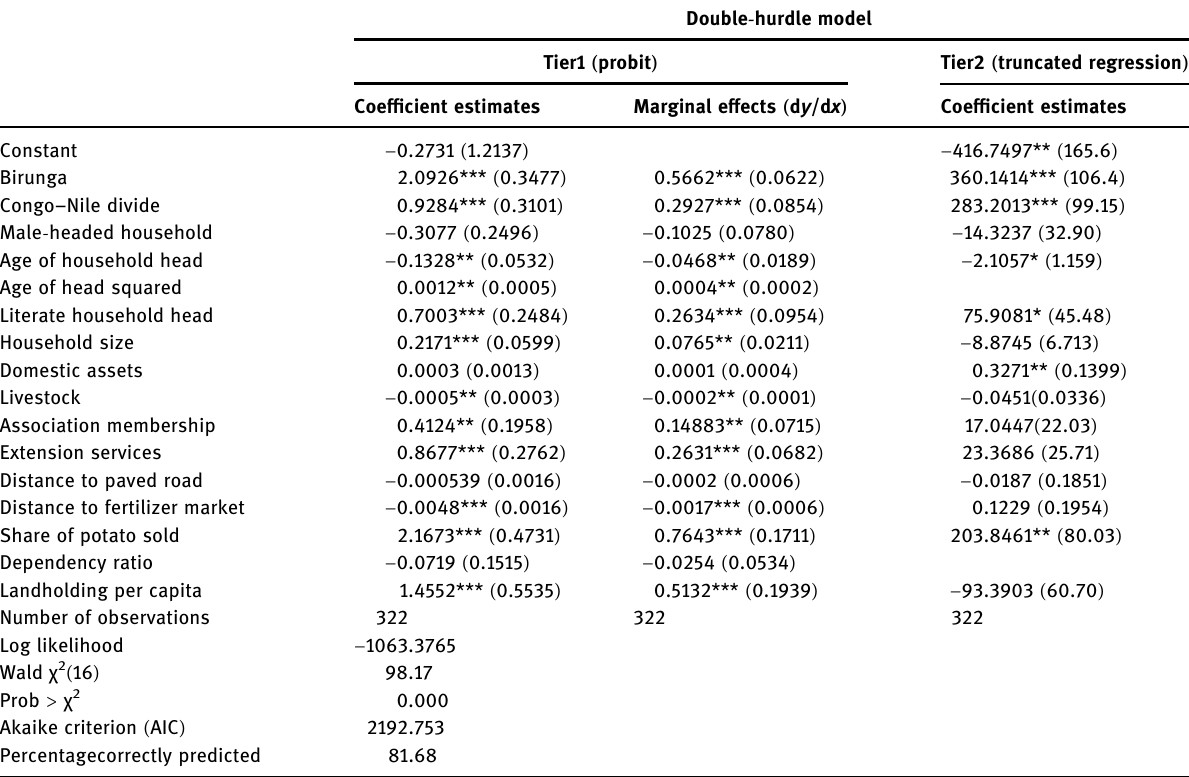
Table 6: Parameter estimates of double hurdle for mineral fertilizer use by smallholder